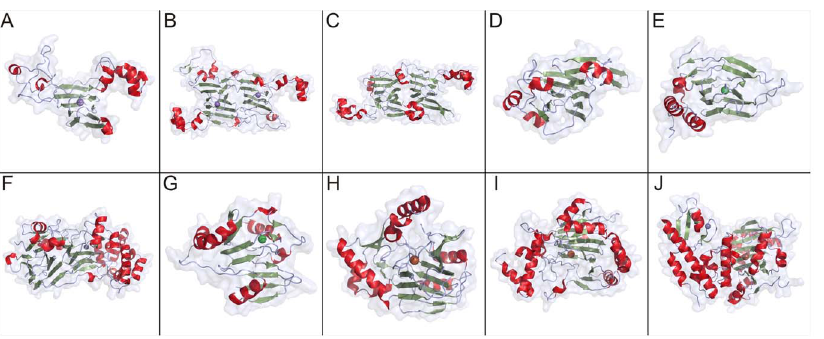
Figure 1. Structures of representative of members of the cupin superfamily. A. oxalate oxidase (PDB code: 2et1) [72], B. oxalate decarboxylase (PDB code: 1uw8) [43], C. seed storage protein Ara h (PDB code: 3s7i) [39], D. NovW, a 4-keto-6-deoxy sugar epimerase (PDB code: 2c0z) [71], E. cysteine dioxygenase (PDB code: 2q4s) [48], F. phosphomannose isomerase (PDB code: 1 pmi) [53] G. acireductone dioxygenase (PDB code: 1 zrr) [62] H. taurine/alpha-ketoglutarate dioxygenase (PDB code: 1os7) [73], I. hypoxia-inducible factor 1-alpha inhibitor (PBD code: 2y0i) [74], J. lysine-specific demethylase 6B (PDB code: 2 xue) [75]. b -sheets are shown in green, a -helices are shown in red, and random coils are shown in grey. Spheres represent bound metal ions. Figures were generated using Pymol (The PyMOL Molecular Graphics System, Schro¨dinger, LLC).